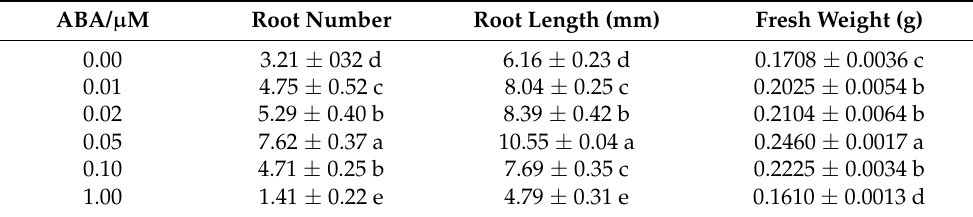
Table 2. Effect of ABA on adventitious root development in cucumber.